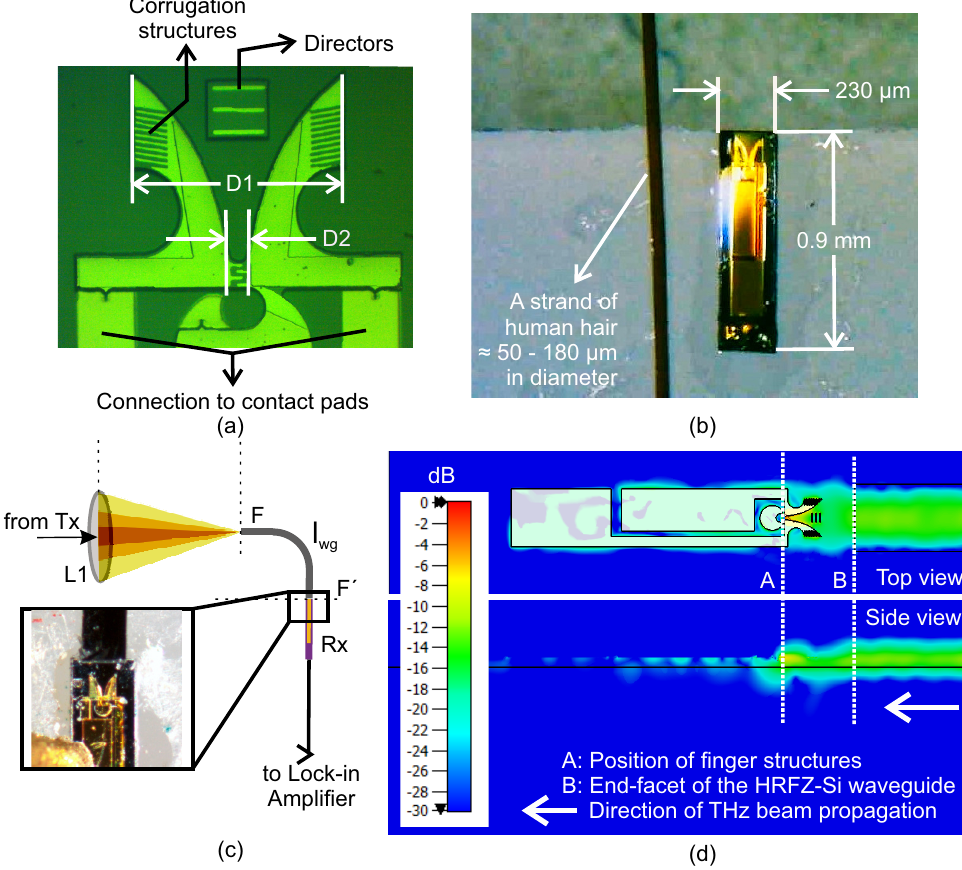
Figure 5. ( a ) Micrograph of a VA fabricated in-house. ( b ) Receiver integrated with a VA, which is ≈ 230 µ m wide, 0.9 mm long and with a substrate thickness of only 32 µ m mounted on HDPE. The substrate is thinner than a human hair. Schematic in ( c ) shows the experimental setup with Vivaldi antenna coupled THz receiver. An actual microscopic image of the coupled waveguide is in the inset. ( d ) shows simulation of the average power flowing from the waveguide into VA at 0.875 THz. The simulated coupling efficiency of the waveguide-VA interface at 0.875 THz is − 4.3